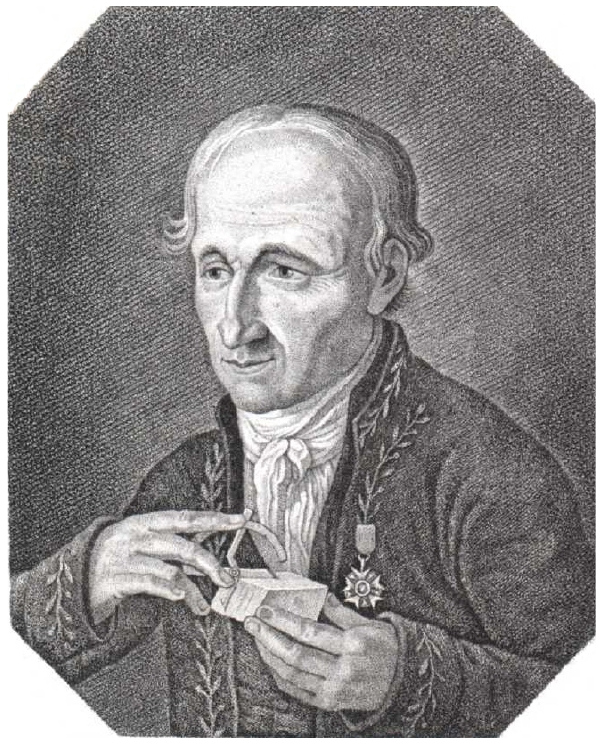
Figure 2. René Just Haüy (1743–1822), abbot and “father of crystallography” pictured measuring a crystal which probably rep- resents Iceland spar. Haüy’s interest in the subject was initially aroused when he found that calcite crystals of various shapes could be cleaved to reveal the “forme primitive” of Fig. 1